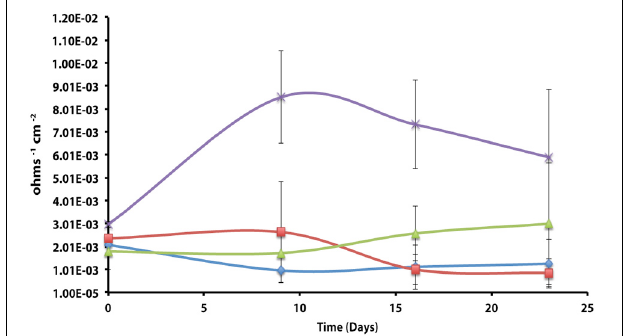
FIGURE 2 | Instantaneous corrosion rates (1/ Rp ) for pure cultures of D. alkanexedens strain ALDC ( ) and M. hungatei strain JF-1 ( ) as well as the syntrophic co-culture ( ) of the two microorganisms (standard deviation incubations n = 3, axenic D. alkanexedens strain ALDC incubations n = 2).